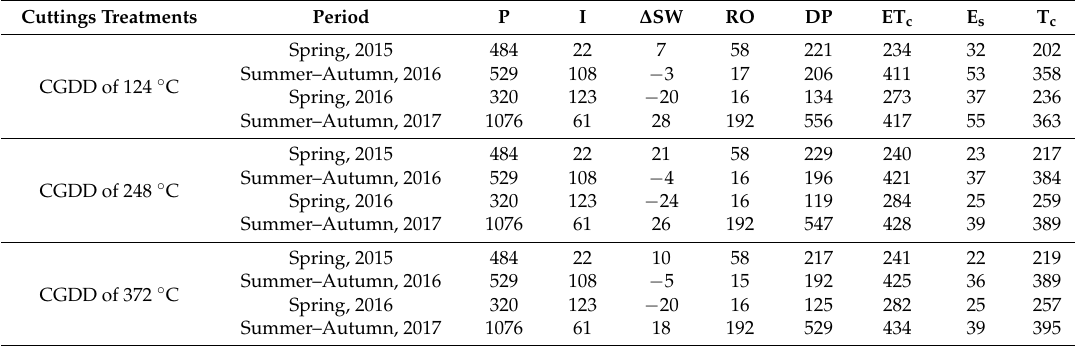
Table 9. Soil water balance terms (mm) for all cutting treatments and all observation periods.